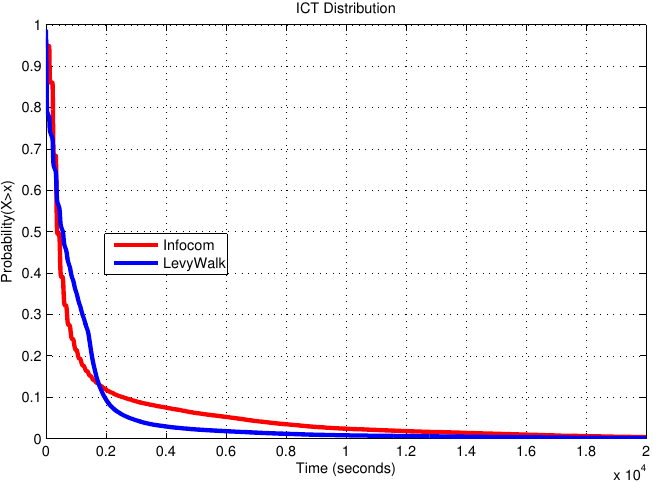
Figure 13. ICT distribution for Infocom traces and Levy Walk in our